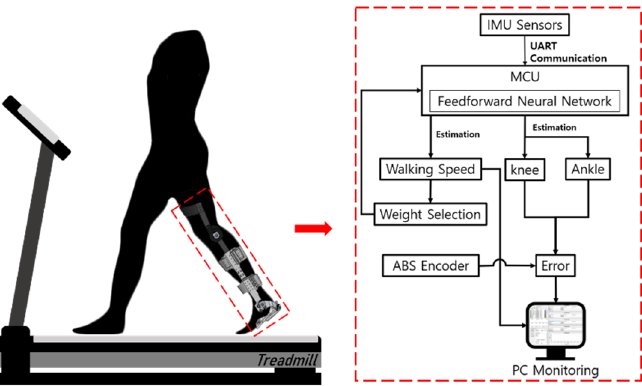
Figure 7. Schematic diagram of the experimental setup for estimation of the joint angle and walk- ing speed.